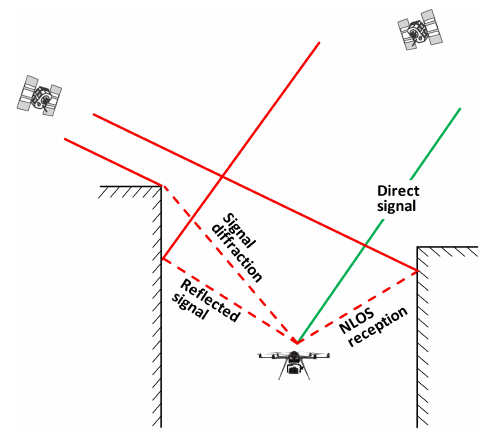
Figure 1. Site-dependent GPS effects, which lead to systematic errors in the direct georeferencing of